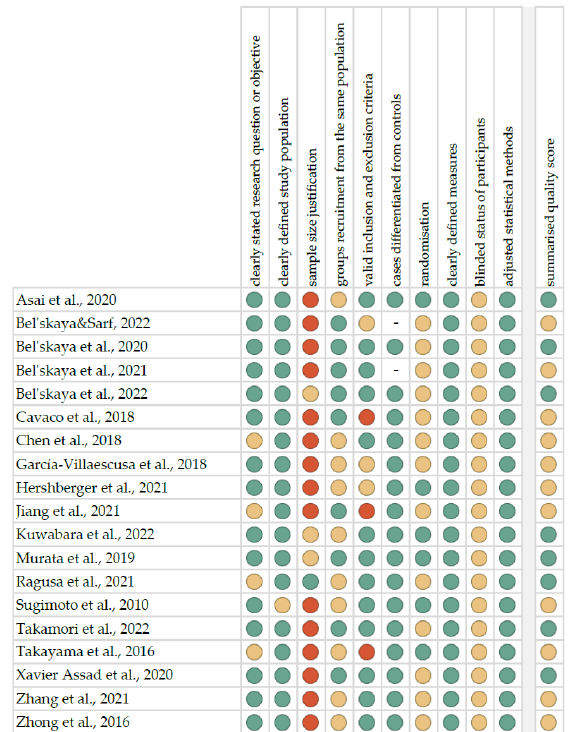
Figure 1. Quality assessment, including the main potential risk of bias (risk level: green — low, yellow — unspecified, red — high; quality score: green — good, yellow — intermediate, red — poor) [36 – 54].